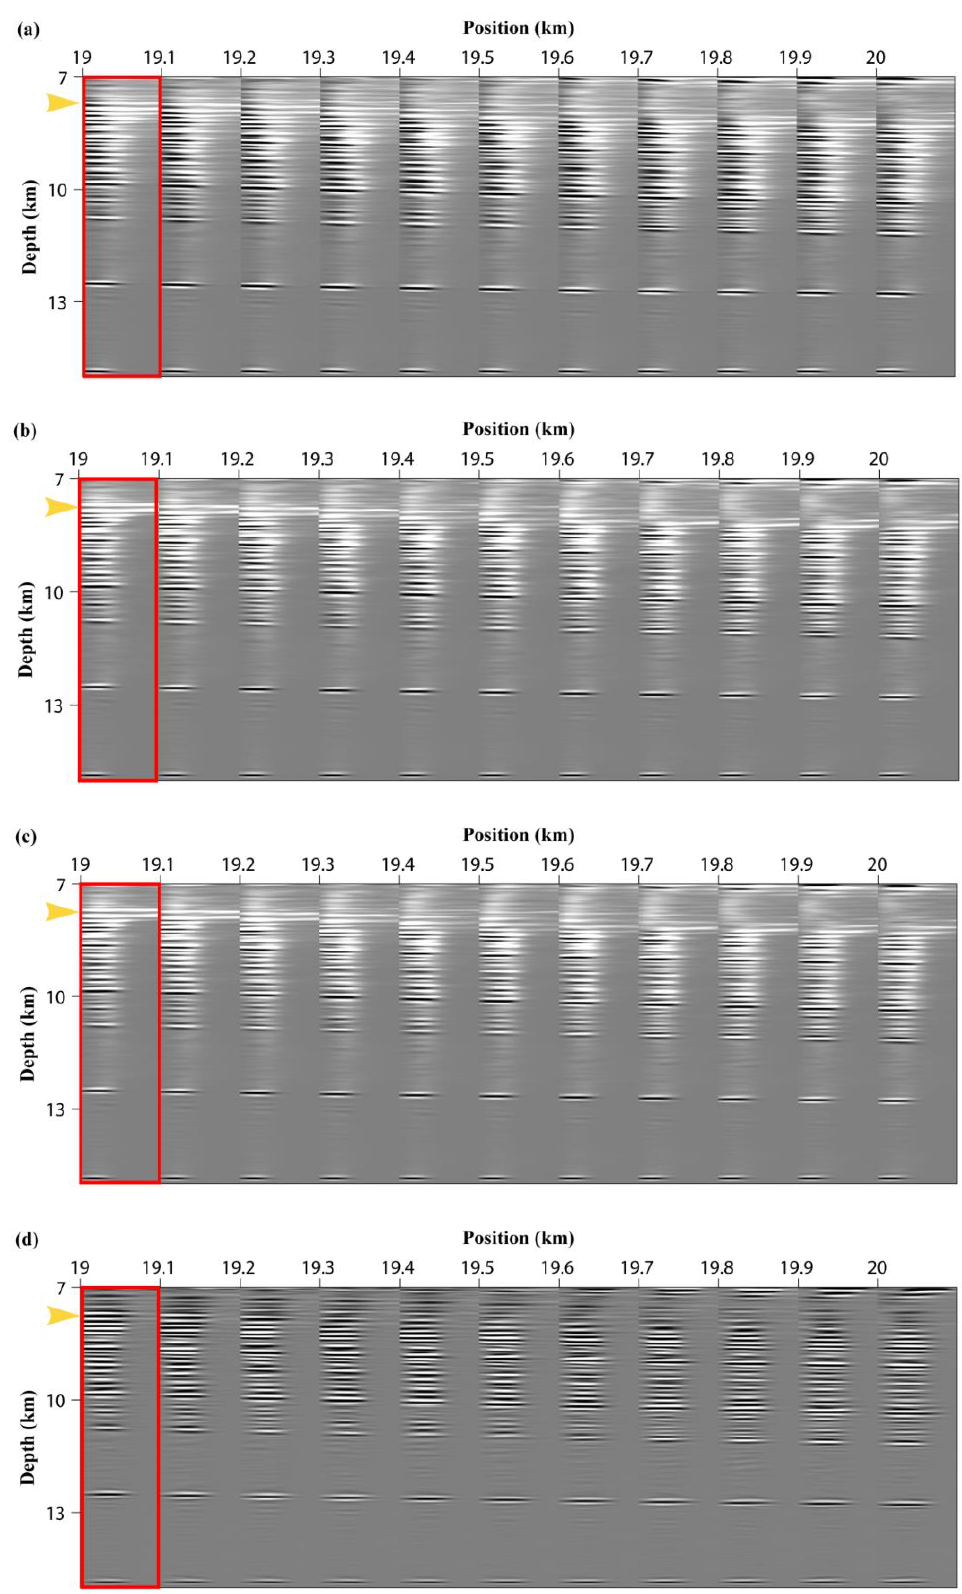
Figure 10. Angle gathers of subsalt area marked by red dashed rectangle in Figure 9 (x = 19~20 km) are generated by using ( a ) Method 1, ( b ) Method 2, ( c ) Method 3 and ( d ) Method 4. The reflection angle range is [0°, 50°]. All four images are regularized to the same amplitude scale.